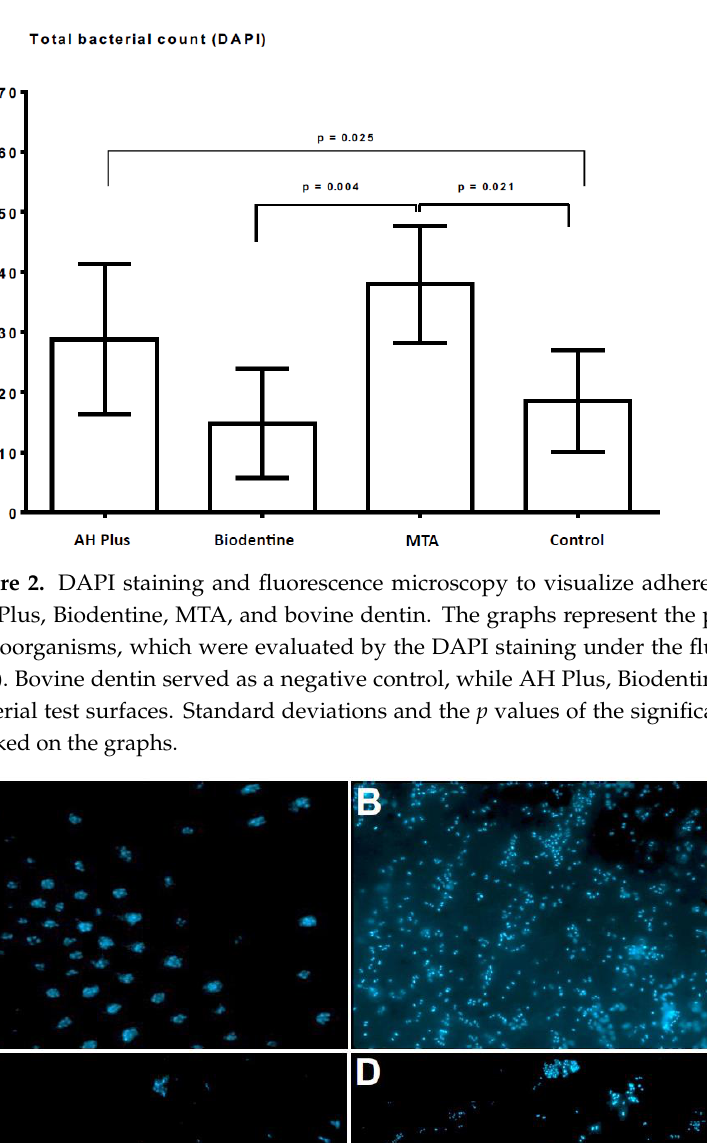
Table 2. The proportion of adherent microorganisms in relation to the surface area of the material and control samples after DAPI staining and fluorescence microscopy.